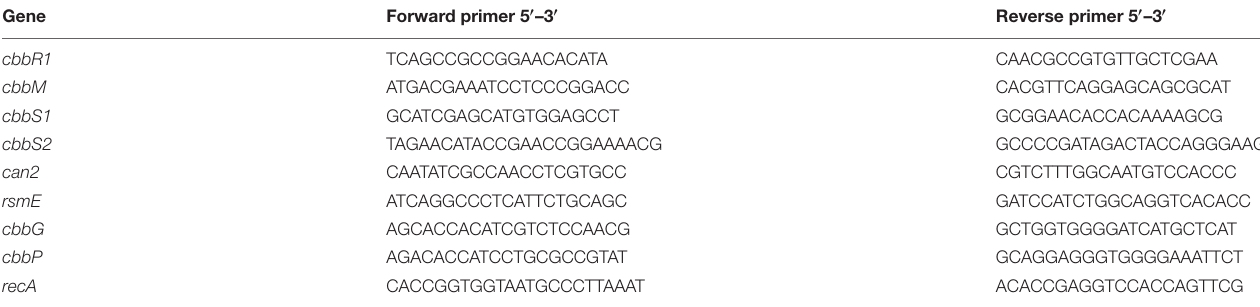
TABLE 1 | PCR primers used in the study. Gene Forward primer 5 (cid:48) –3 (cid:48) Reverse primer 5 (cid:48) –3